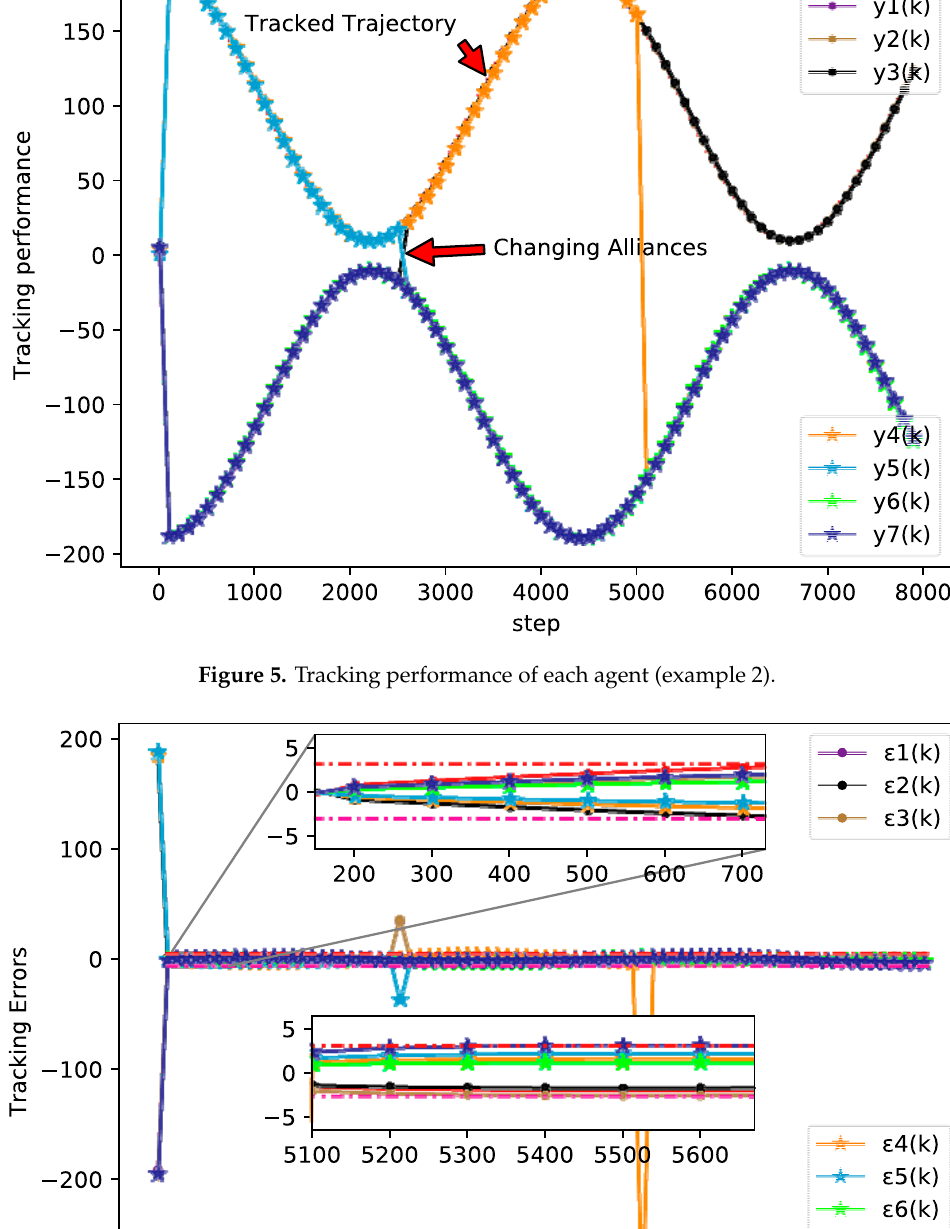
Figure 6. Tracking errors of each agent (example 2).